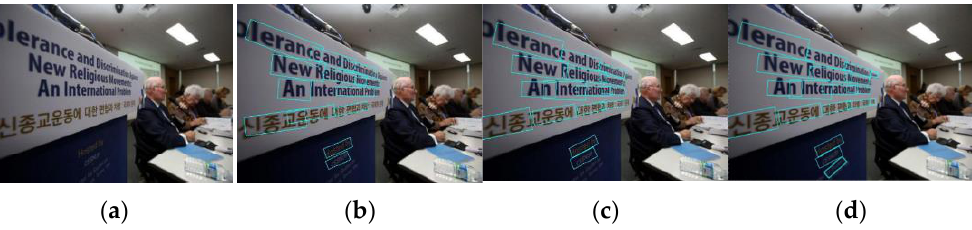
Figure 8. Comparison of the detection effect on complex natural background text. ( a ) Original complex background text; ( b ) EAST algorithm; ( c ) Hybrid feature pyramid algorithm; ( d ) The algorithm of this paper.